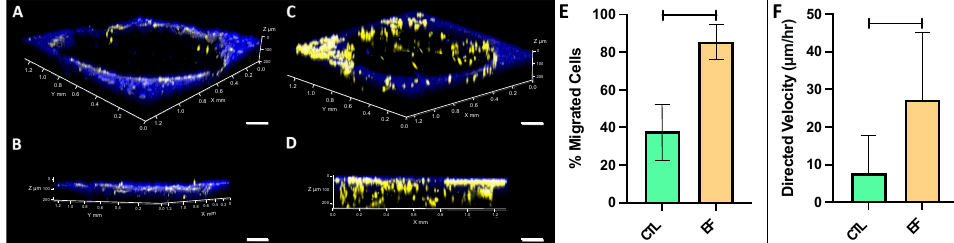
Figure 8. Representative confocal images of DiI ‐ stained FLS migrating into DAPI ‐ labeled bovine cartilage defect. ( A ) Top and ( B ) side view of control (CTL) explants showing minimal FLS migration into the cartilage construct. ( C ) Top and ( D ) side view of explant exposed to DC EFs for 3 h showing significant FLS migration through the depth of the defect region (Scale bar = 200 μ m). ( E ) Percent migration and ( F ) directed velocity of FLS into the cartilage defect for CTL and EF treated groups ( n = 4 cartilage explants).